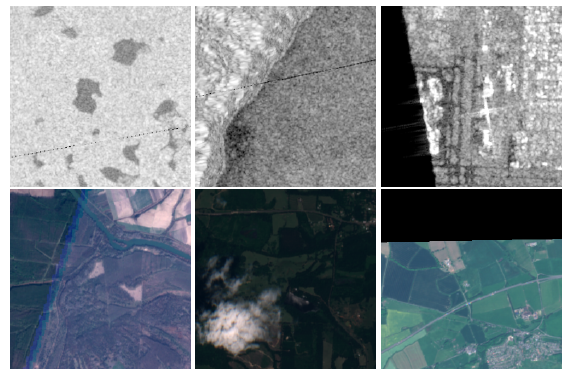
Figure 2. Examples for manually removed SAR (top row) and optical patches (bottom) row).